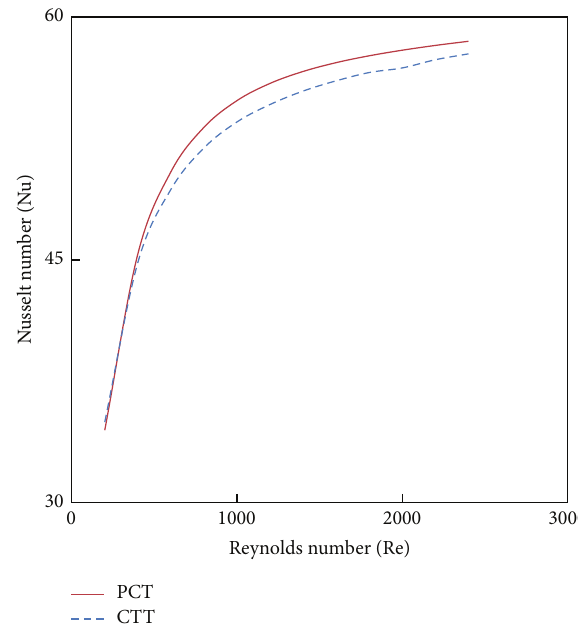
Figure 11: The effect of twist configuration with 4% CuO nanofluid on Nusselt number.